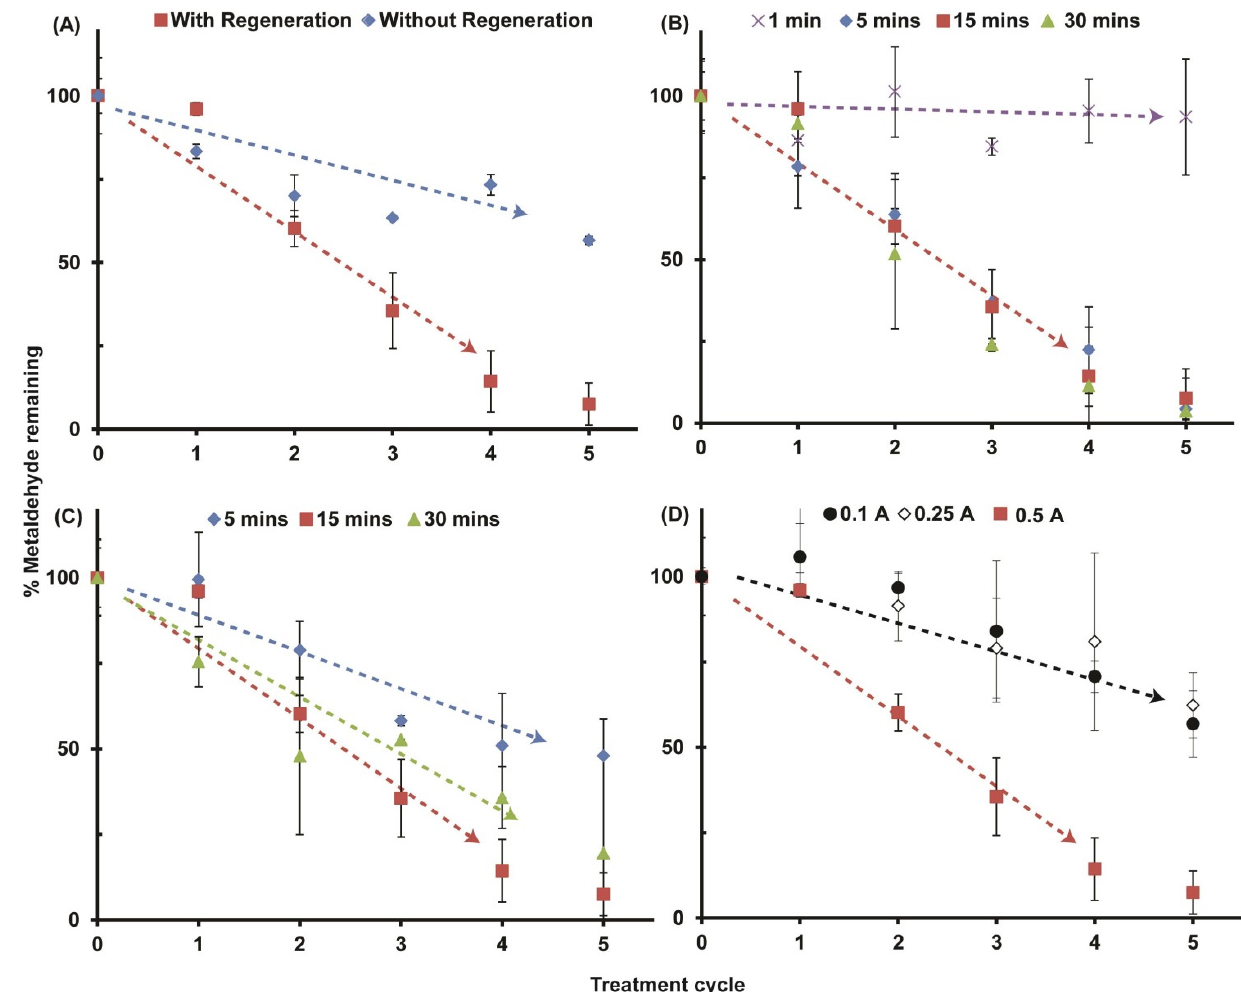
Figure 3. Metaldehyde remaining (expressed as a percentage of initial concentration ~8000 µg/L) after successive treatment cycles ( A ) with and without regeneration (15 min; current 0.5 A) and mixing (15 min); under ( B ) varying mixing times at constant regeneration times of 15 min and current of 0.5 A; ( C ) varying regeneration times at constant mixing time of 15 min and current of 0.5 A; and ( D ) varying current at constant mixing time (15 min) and regeneration time (15 min; current 0.1 A, 0.25 A and 0.5 A). Dotted arrows indicate generalized trends, when there are multiple comparable trends only a single arrow is given. Bars indicate the error, when they are not visible the error bar is smaller than the symbol